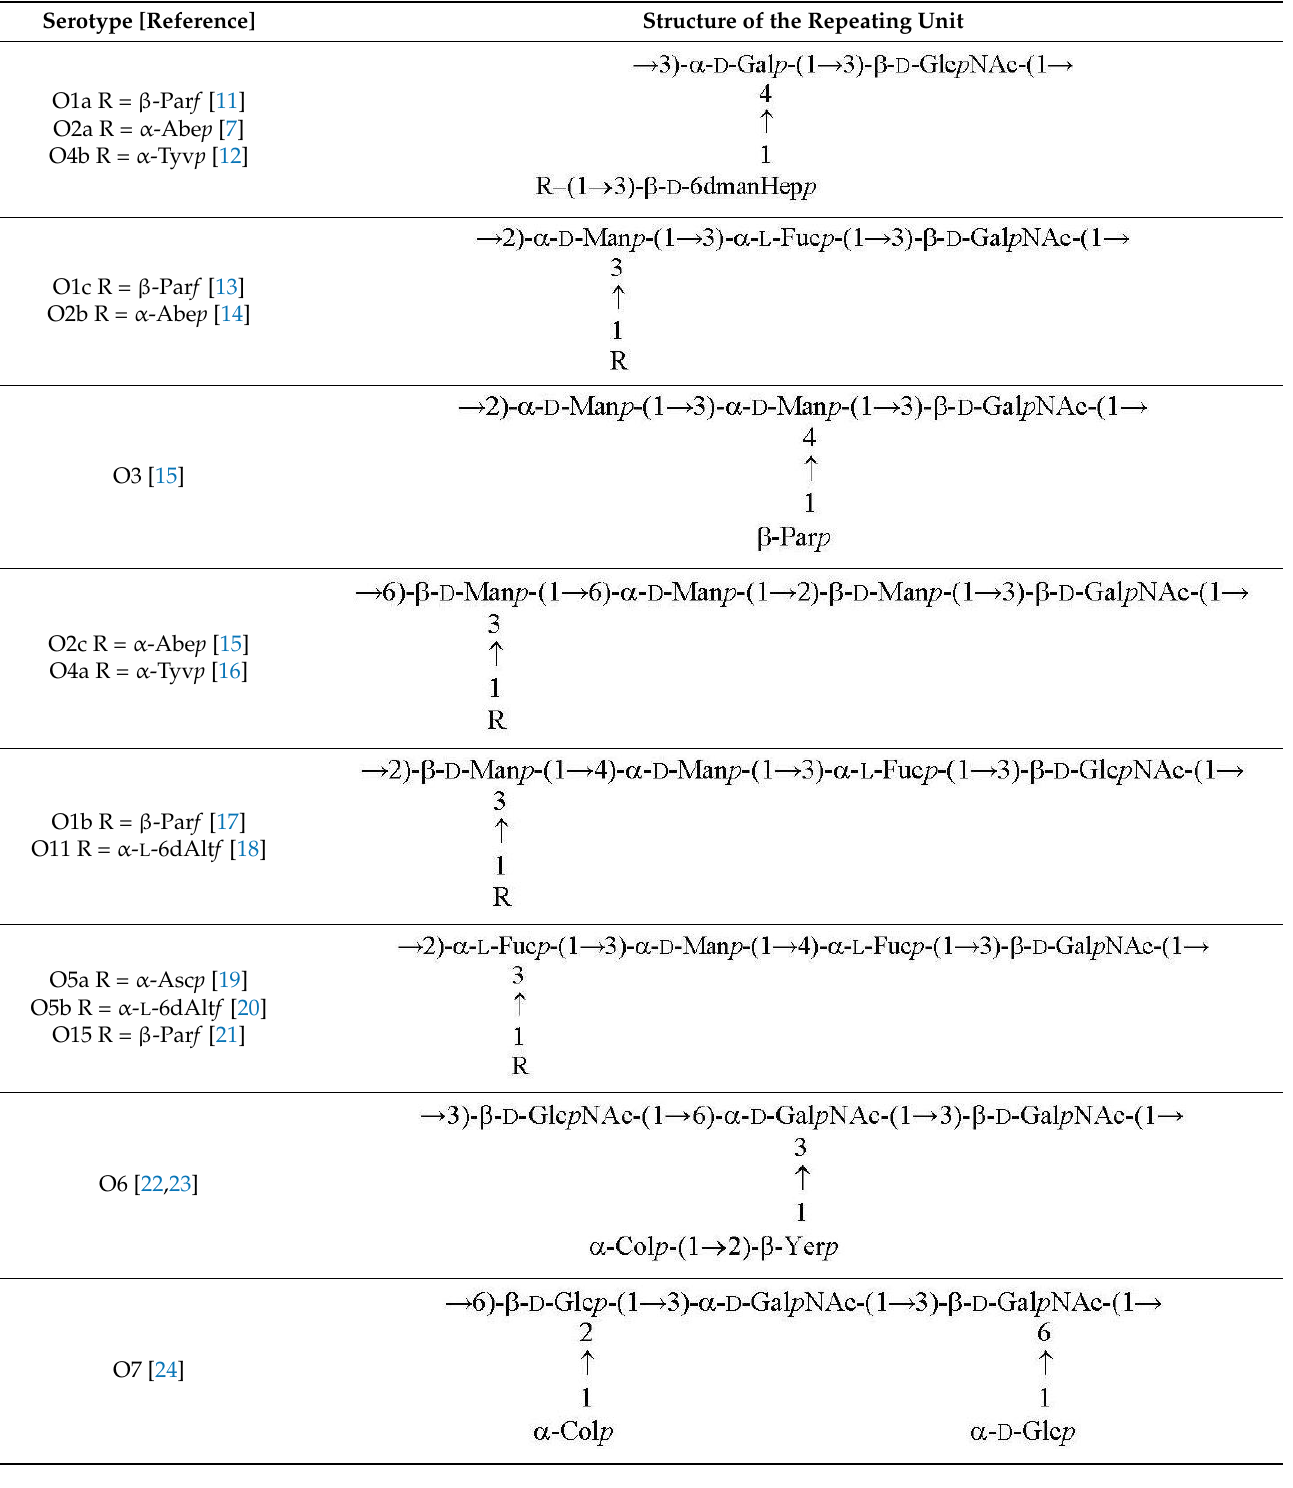
Table 1. Structures of the O-specific polysaccharides of Y. pseudotuberculosis .